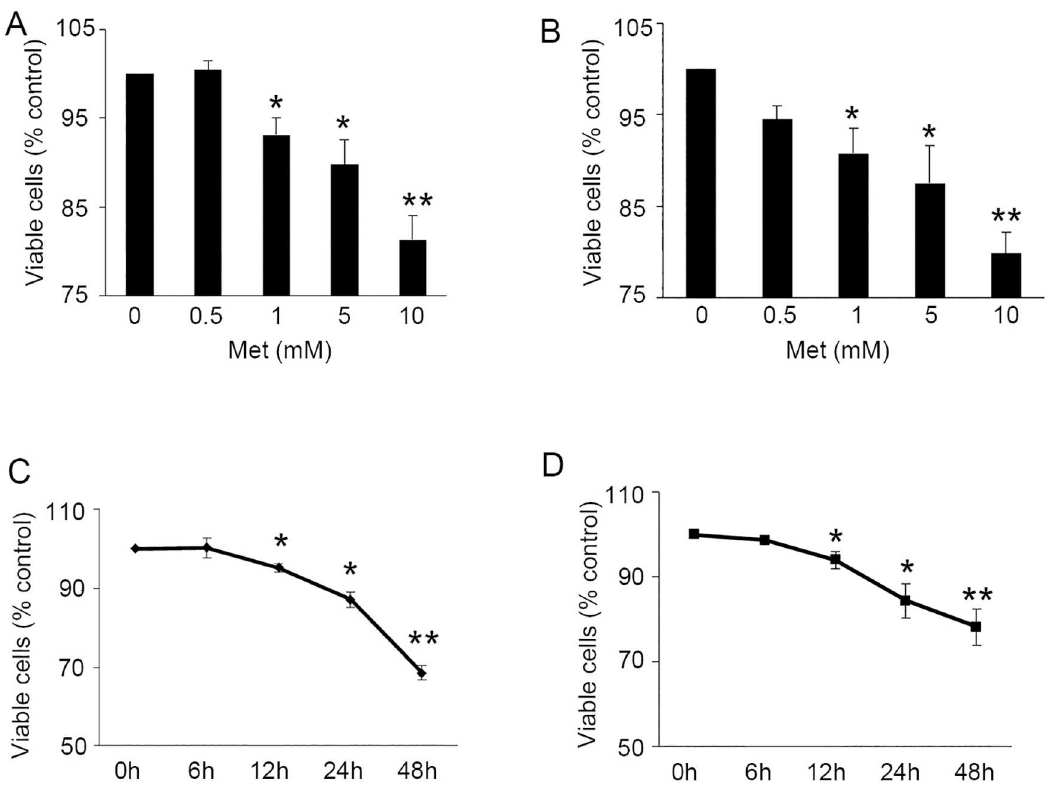
Fig 1. Metformin inhibits human benign prostatic epithelial cell growth. A-B: Cell viabilityof BPH-1 (A) and P69 (B) 24 hours after treatment with variousdoses of metformin. MTS test was performed as describedin Materialsand Methods. The results are expressedas percent of viablecells comparedwith control group. C-D: Cell viabilityof BPH-1 (C) and P69 (D) after the treatment of 5 mM metformin in different times. * , P < 0.05; ** , P < 0.001comparedwith control